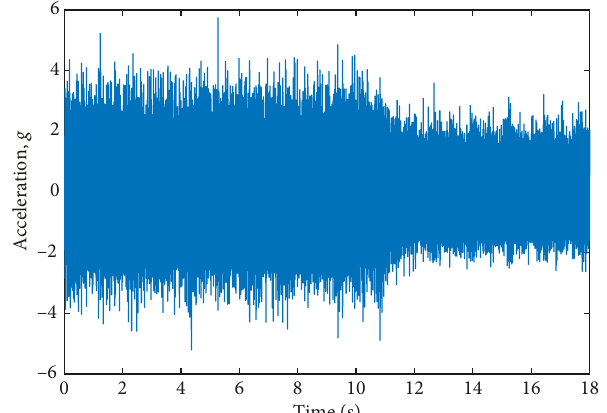
Figure 16: Time-domain diagram of gearbox vibration active